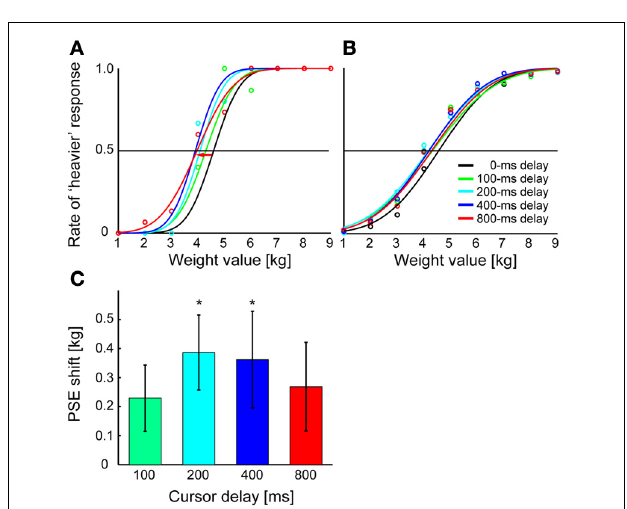
washeavier.Theinstructionwasonthescreenfromtheendofthelasttrialuntil theonsetofthenexttrial(targetappearance).Theyellowlettersandarrowsare usedtoexplaineachdisplay, butthey arenot shown onthescreen duringthe actualexperiment.